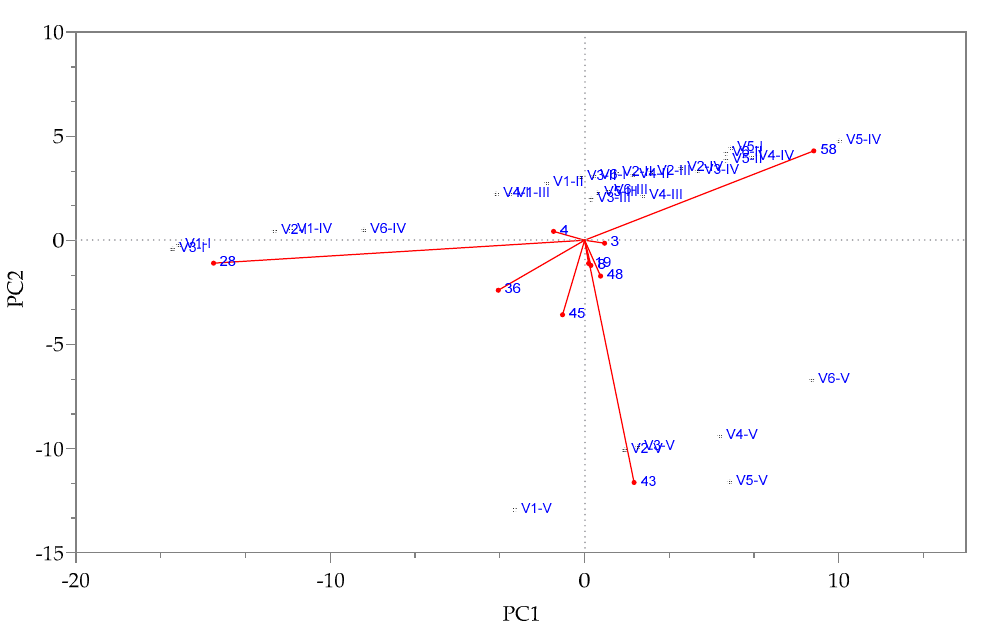
Figure 1. PCA analysis on Feteasc ă regal ă samples. V1—Endozym Thiol ® , AEB; V2—Endozym